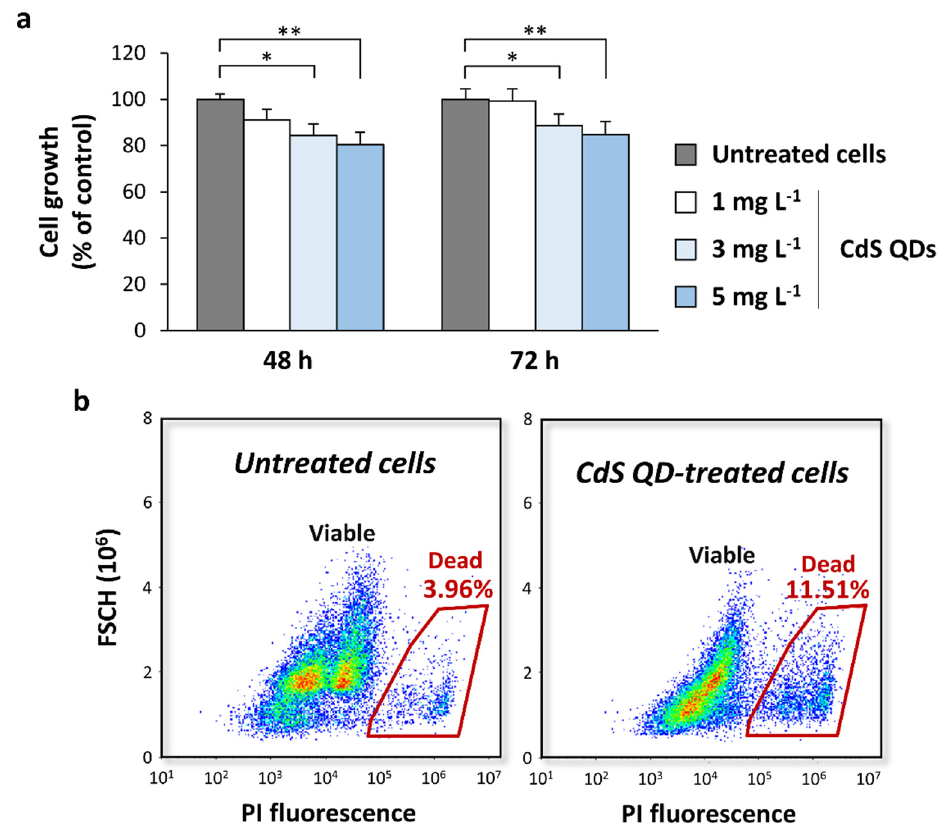
Figure 2. CdS QDs do not significantly alter the yeast growth in sporulation medium. ( a ) Z239-6B-6B diploid strain was grown in sporulation medium supplemented with CdS QDs (1–10 mg L − 1 ), and growth curves were recorded for 48 h and 72 h at 28 ◦ C. The results are expressed as percentage of cell growth (OD 600 ) of CdS QD-treated cells relative to the control (untreated) cells (set to 100%). The values shown in the histograms are the mean ( ± standard deviation) of three independent experiments performed in triplicate. Significance was determined by one-way ANOVA with Dunnett’s multiple-comparisons test. * p < 0.05; ** p < 0.01. ( b ) Cell viability was also determined using flow-cytometry (FC) analysis. After CdS QD treatment (5 mg L − 1 ), the cells were stained with propidium iodide (PI) and analyzed with FC. Representative dot-plots of forward-scatter signals (FSCH) versus PI fluorescence intensity are shown, and the percentages of dead (PI + ) cells were indicated for each sample. Significance was determined by t-test ( p < 0.05).